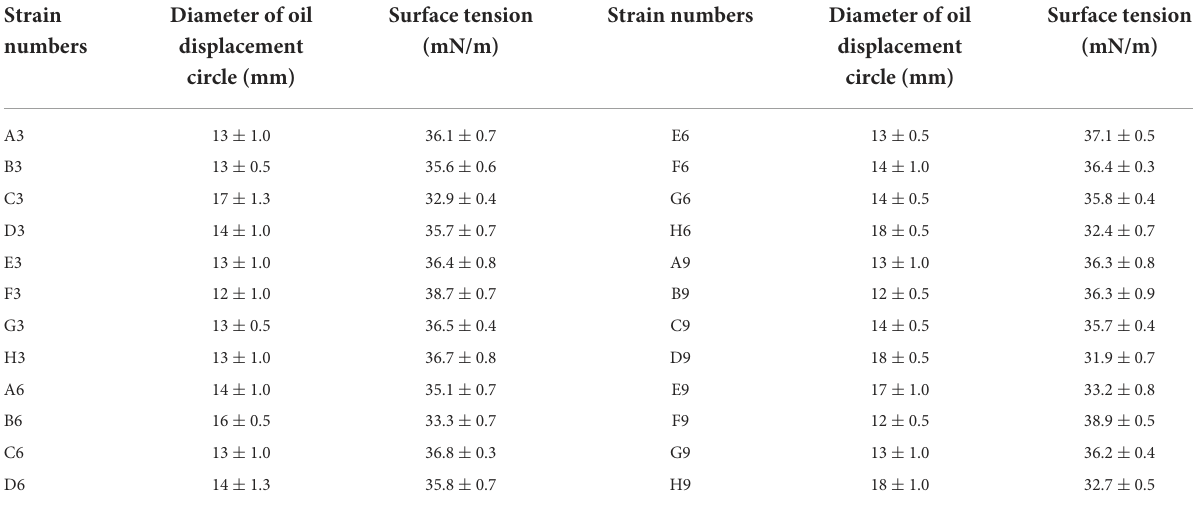
TABLE 1 Microbial strains screened from the simulated environmental sample.